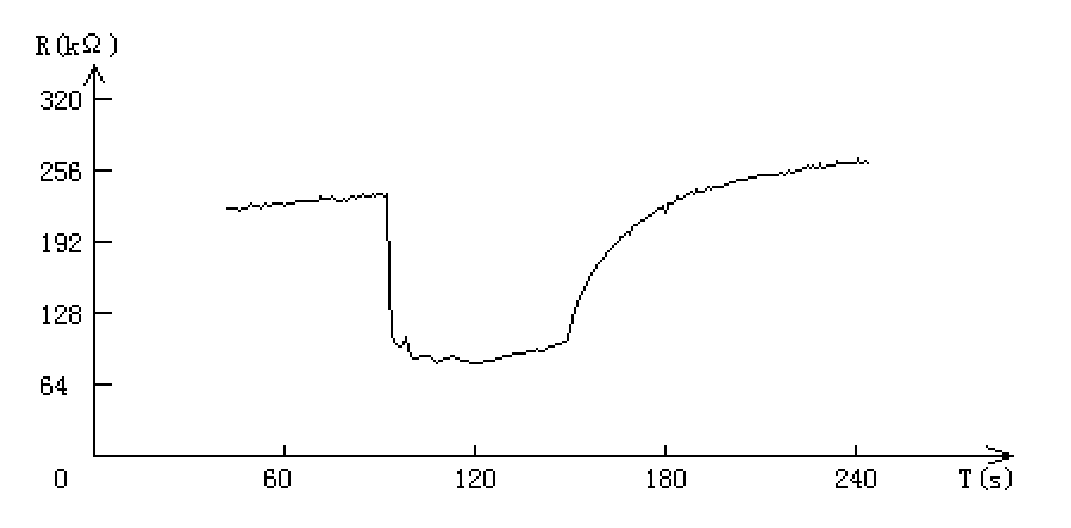
O gas sensor to a nitrogen/ 500 ppm CO/nitrogen 2 4